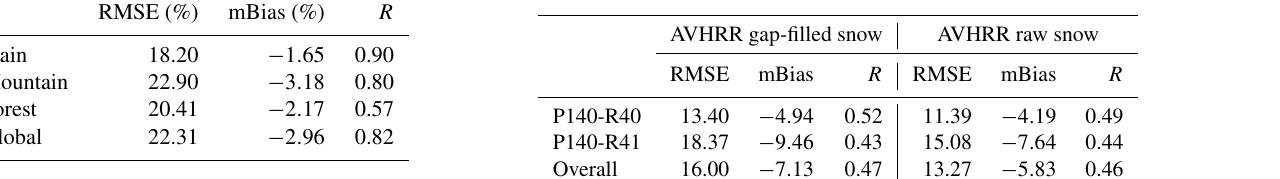
Table 5. Summary of accuracies of AVHRR raw and AVHRR gap- filled snow data with Landsat5 TM snow over P140-R40 and P140-